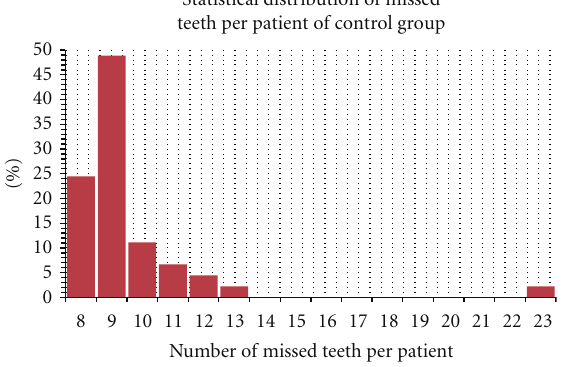
Figure 1: Student’s t -test performed for number of missed teeth on control Parkinson’s patient group.